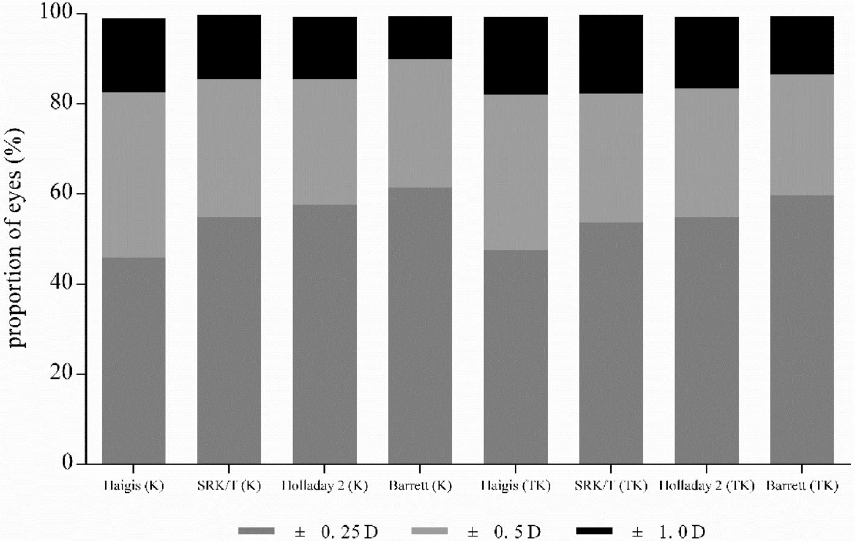
Figure 2. Proportional graph of eyes within ± 0.25 D, ± 0.50 D, and ± 1.00 D of prediction error of each formula using conventional keratometry and total keratometry. K conventional keratometry, TK total keratometry.